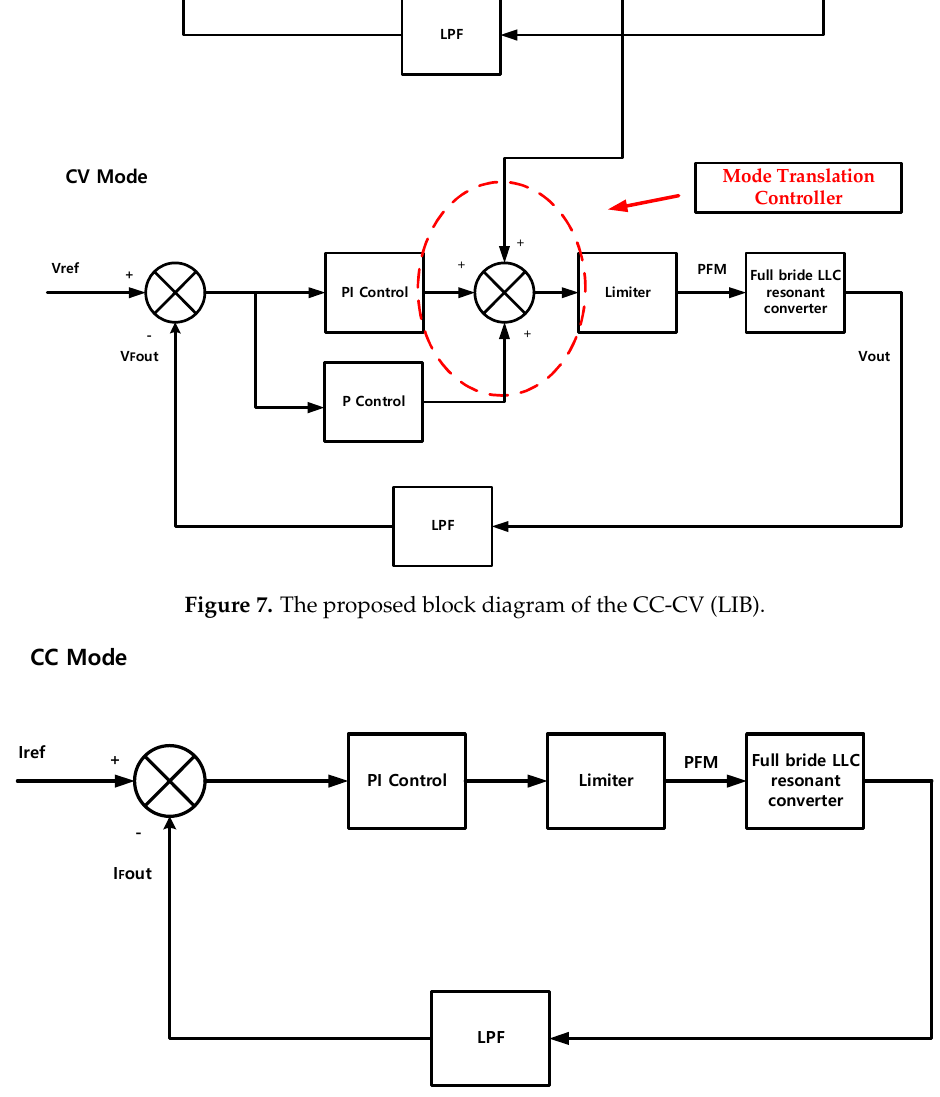
Figure 8. The proposed block diagram of CC (the SC case).